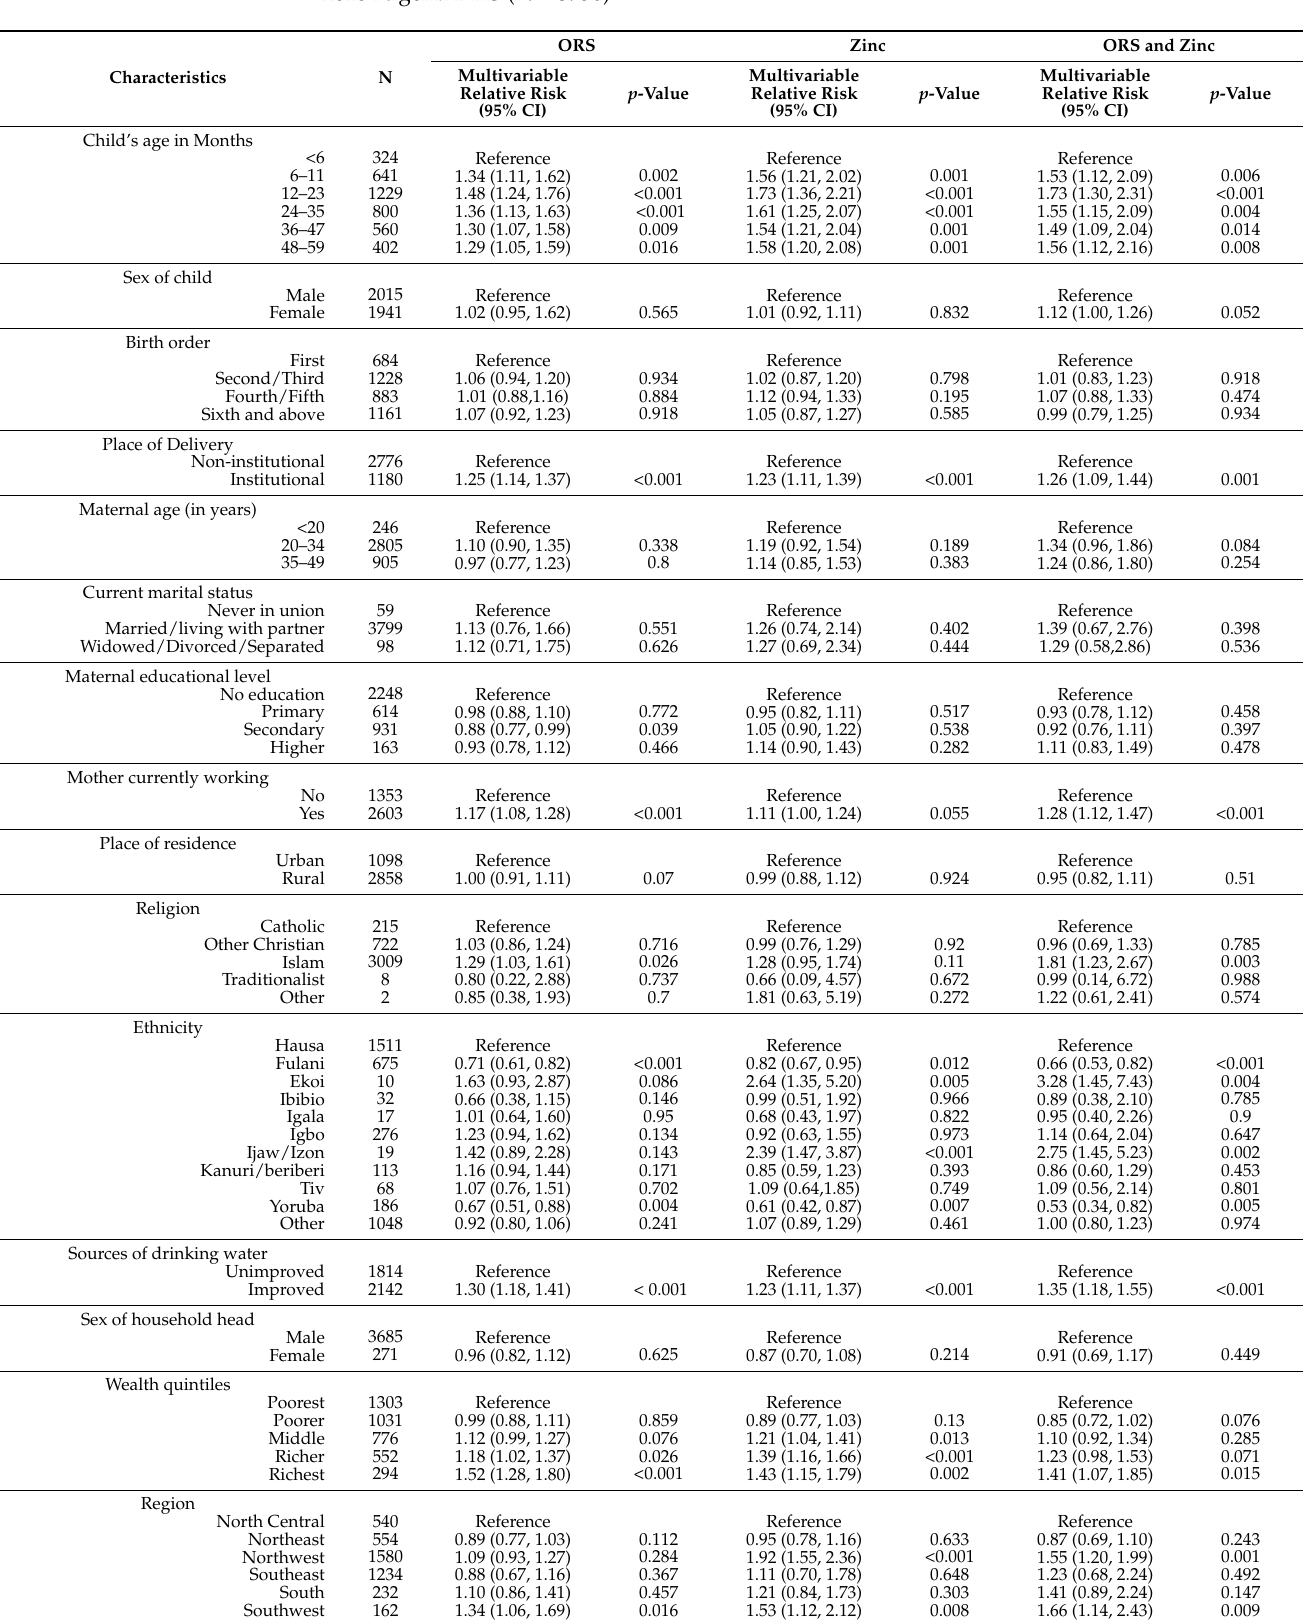
Table 3. Multivariable relative risks for reported receipt of oral rehydration solution (ORS), zinc and ORS and zinc treatment for children with diarrhea during the 2 weeks prior to the survey in the 2018 Nigeria DHS (N =